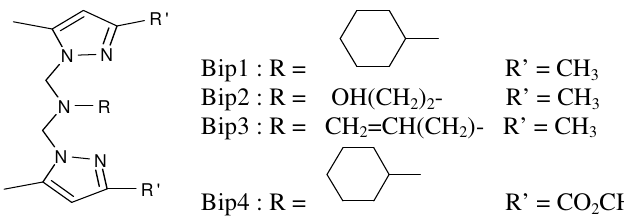
Figure 1. Molecular structures of the investigated